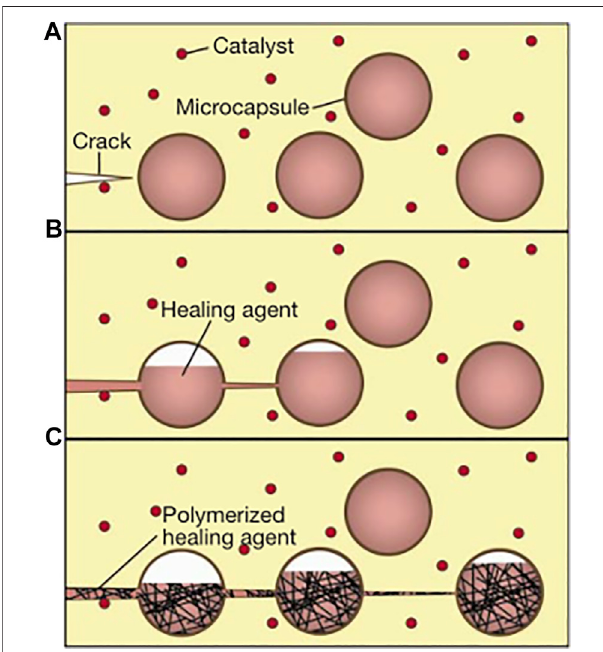
FIGURE 7 | Schematic diagram of autonomic healing concept. (A) cracks appeared in the substrate; (B) release of the healing agent loaded in microcapsules ruptured by cracks; and (C) polymerization reaction between the healing agent and the catalyst (White et al., 2001).